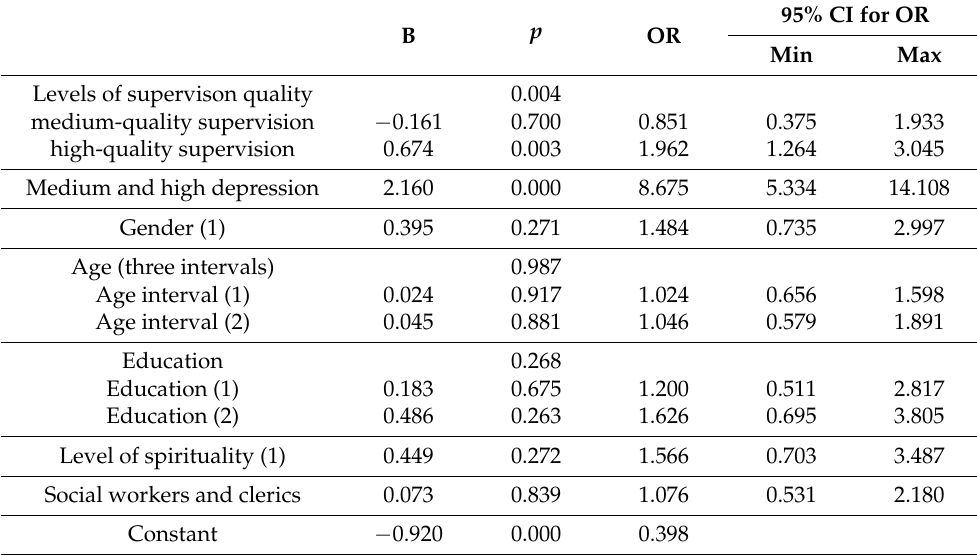
Table 3. Factors influencing burnout in social workers and